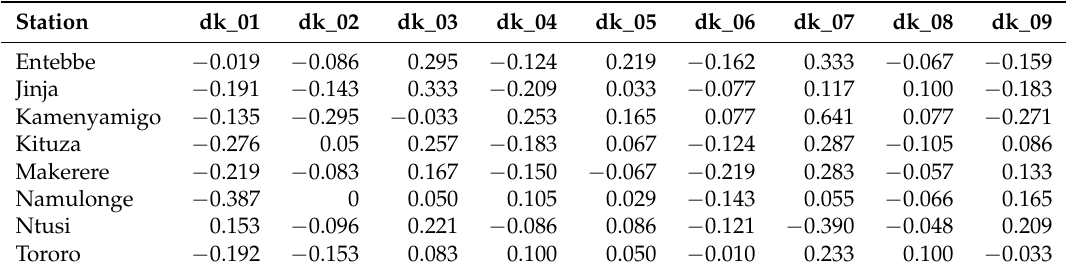
Table 5. MK results for dekadal accumulated